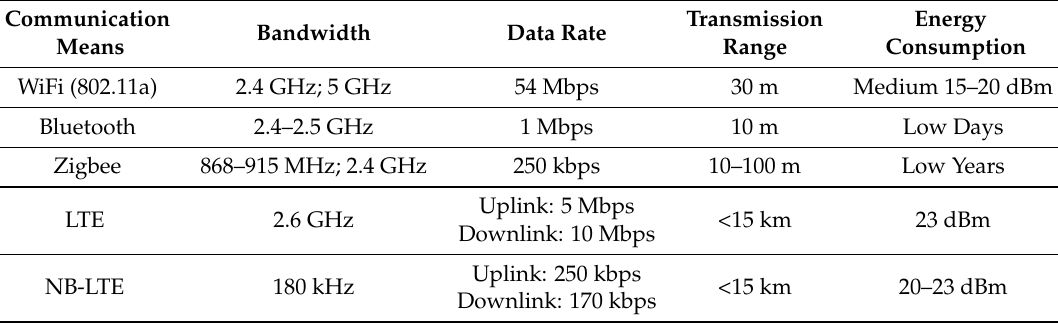
Table 4. Documented Characteristics for Different Communication